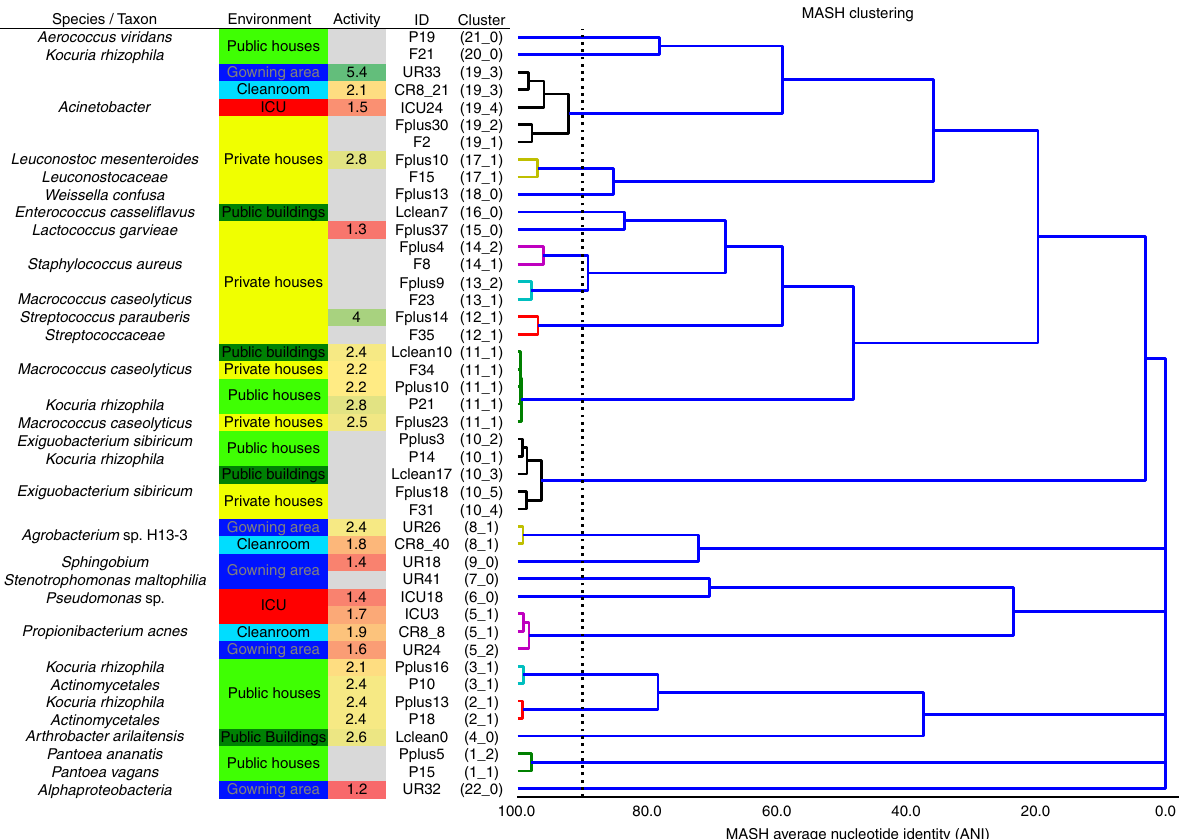
Fig. 4 An overview of reconstructed genomes. High-quality binned genomes clustered by average nucleotide identity (ANI), resolved to highest taxonomic levels, respective built environment origins, and respective replication rates (activity). Color code for column environment: blue (cleanroom facility); red (intensive care unit); dark green (public buildings); light green (public houses); yellow (private